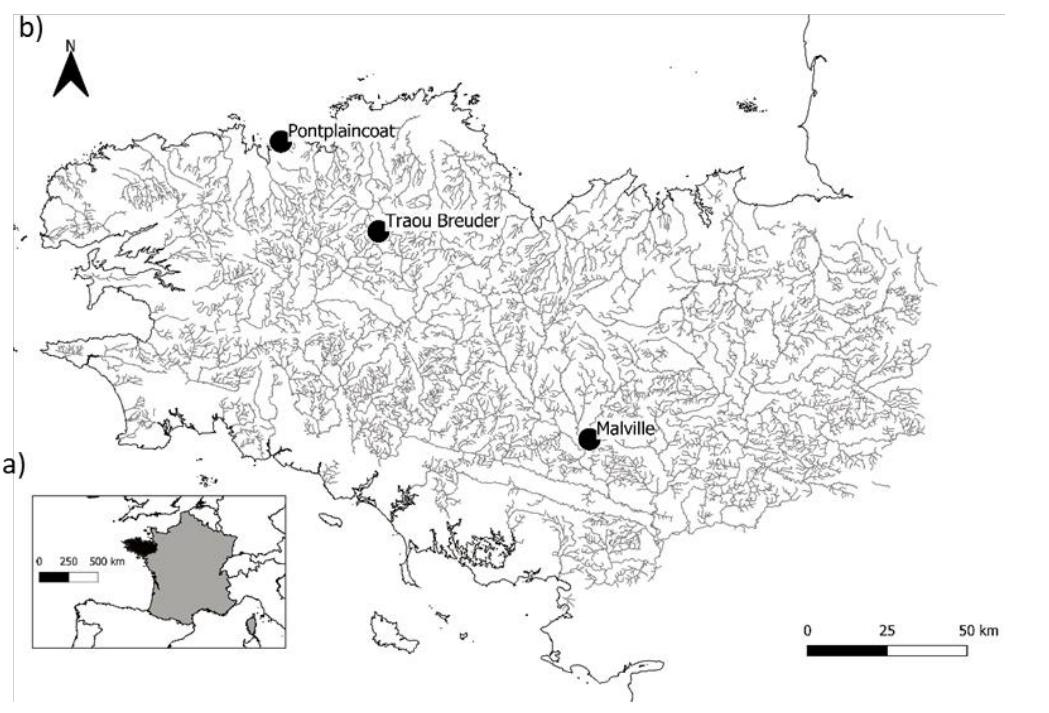
Figure 1. Maps of ( a ) France (grey) with Brittany region (black), and ( b ) Brittany region showing the locations of the 3 restoration sites. Grey lines represent the stream networks of the region. Table 1. Proportion (%) of land use per watershed according to Corine Land Cover 2018 data.